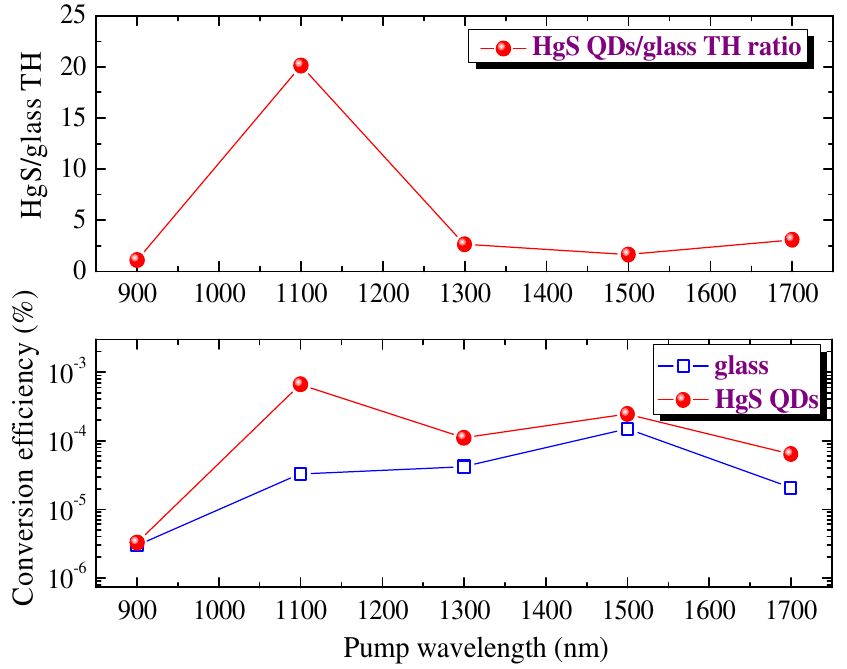
Figure 10. Spectral dependencies of the TH yields from HgS QD film and pure silica glass plate. ( Upper panel ): the ratio of TH yields from the film + plate and pure plate. ( Bottom panel ): absolute values of TH conversion efficiencies in the case of film + plate (red diamonds) and plate (blue, empty squares).